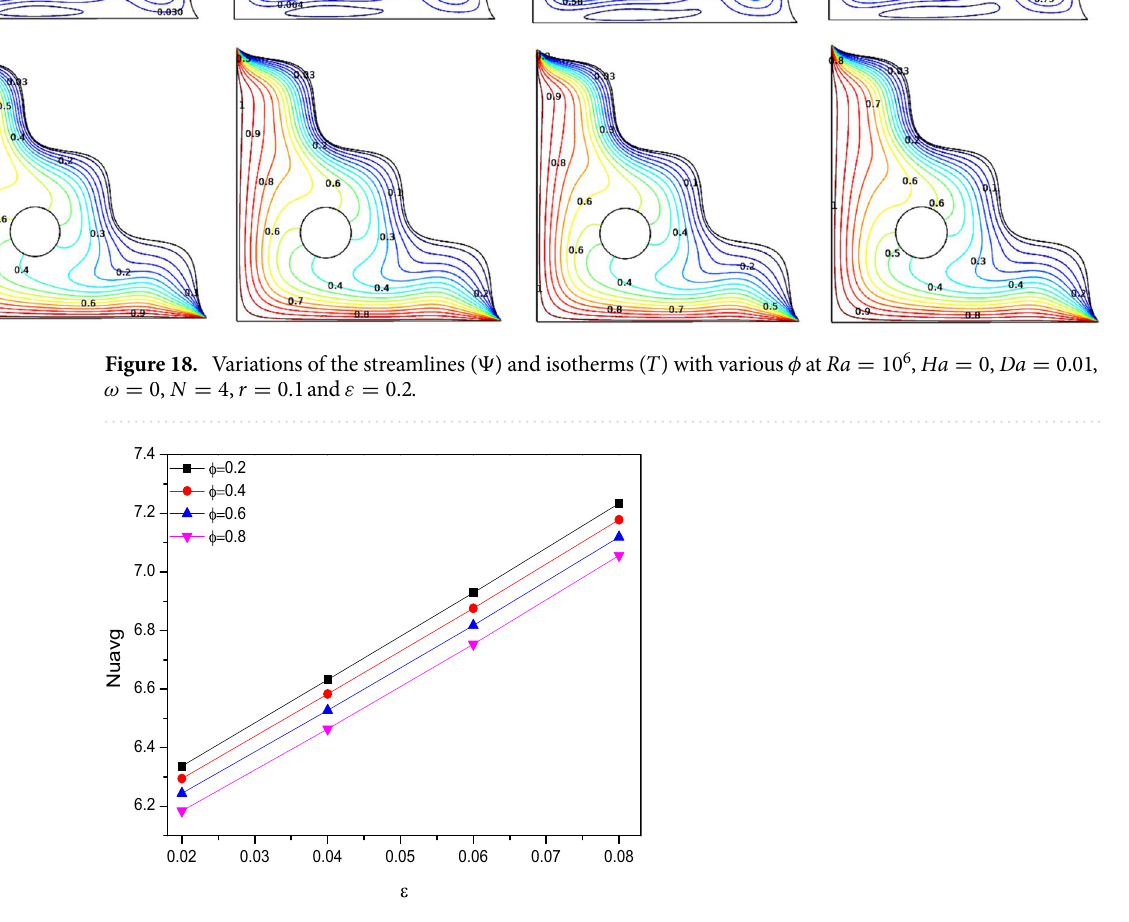
Figure 19. Variations of Nu avg with φ for diverse ε when Ra = 10 6 , ω = 0 , Da = 0.01 , N = 4 , r = 0.1 and Ha = 0